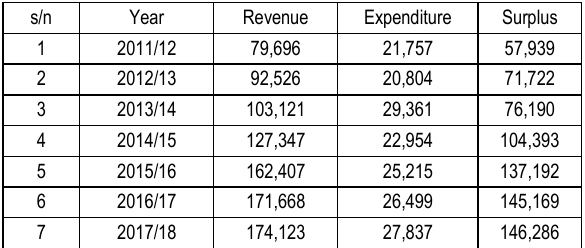
Table 2. Forecast of revenue and expenditure of Mtubatuba Municipality between 2011 and